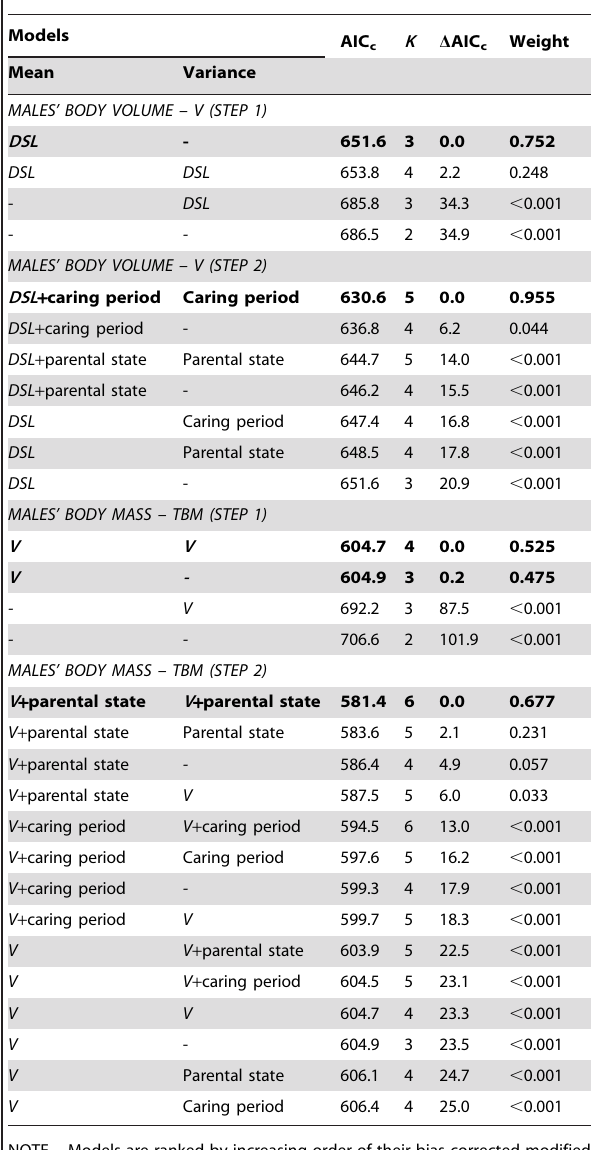
Table 3. Summary of the model selection statistics for the analysis that evaluated the relationship between paternal care and the mean and the variance of body condition proxies (controlled by structural body size) of Iporangaia